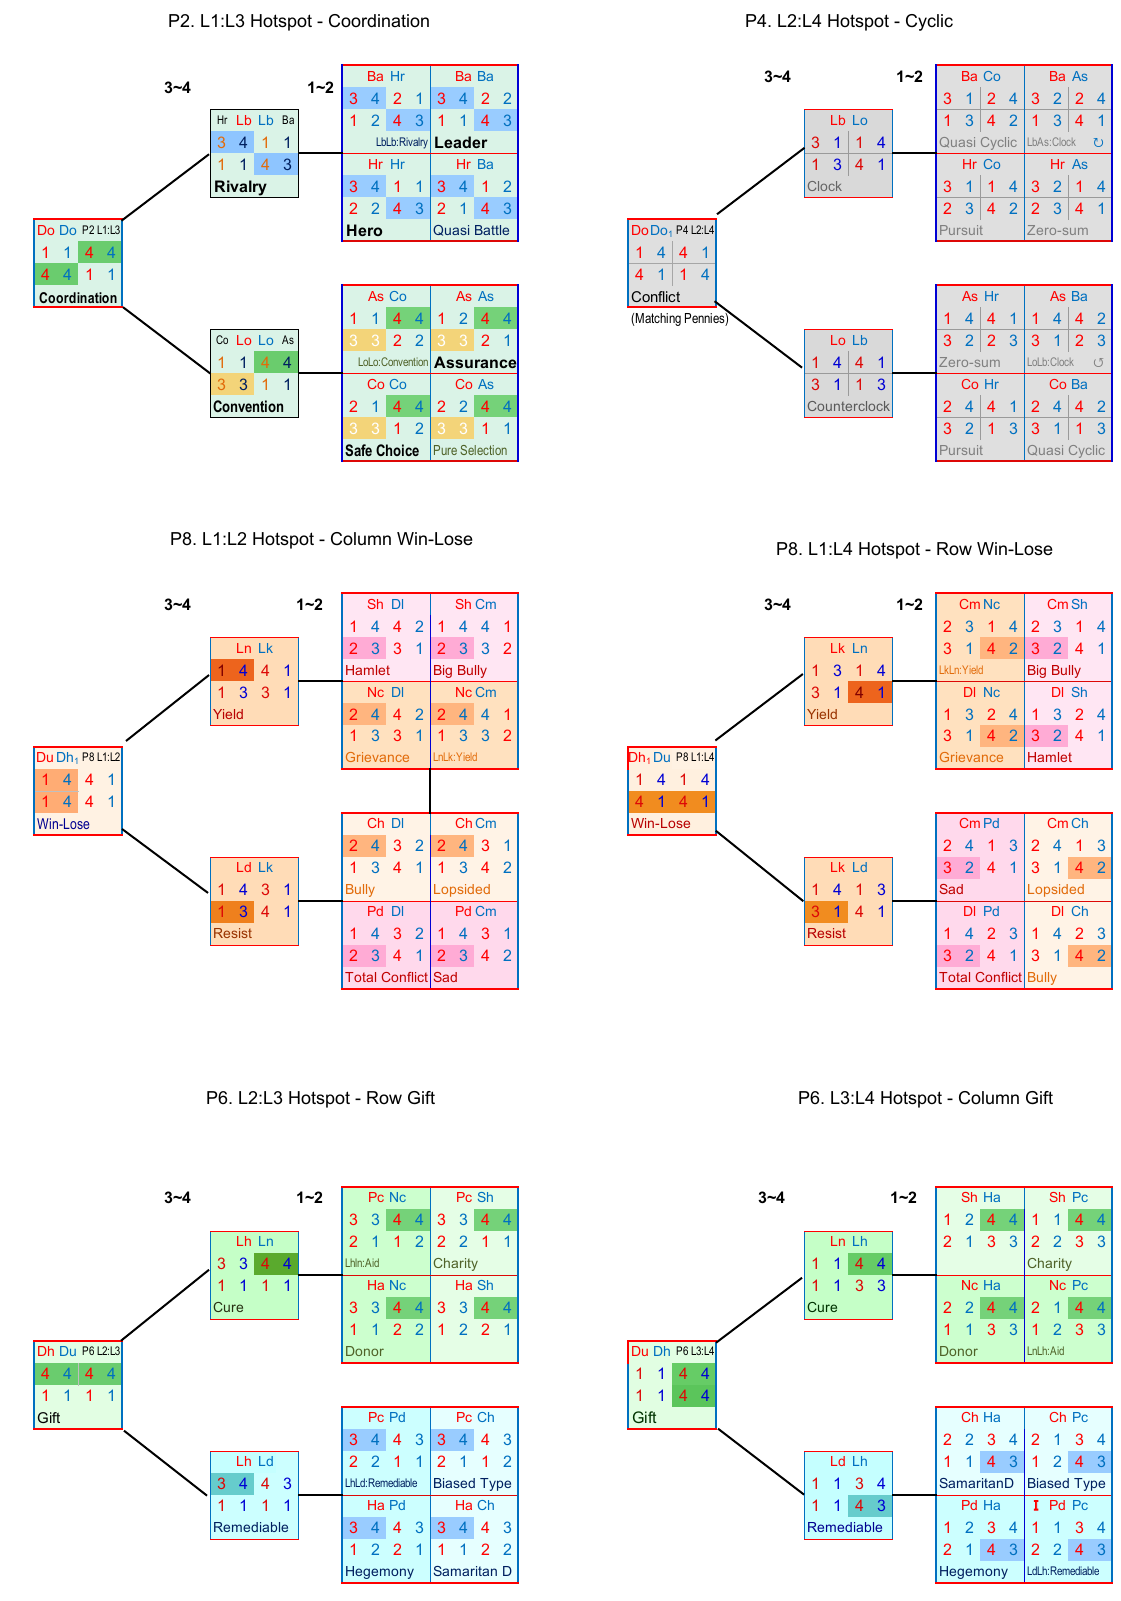
Figure A1. Hotspot families. Primal archetypes for Coordination, Conflict, Win-lose, and Gift differentiate into two tiles composed of four strict ordinal games linked by low swaps